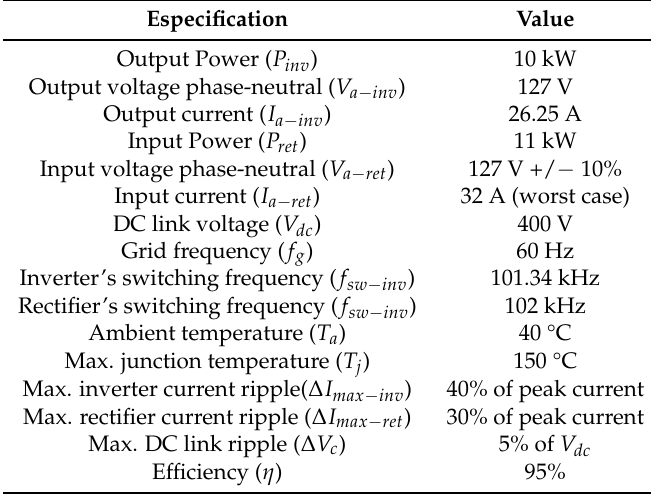
Table 1. Main specifications and design